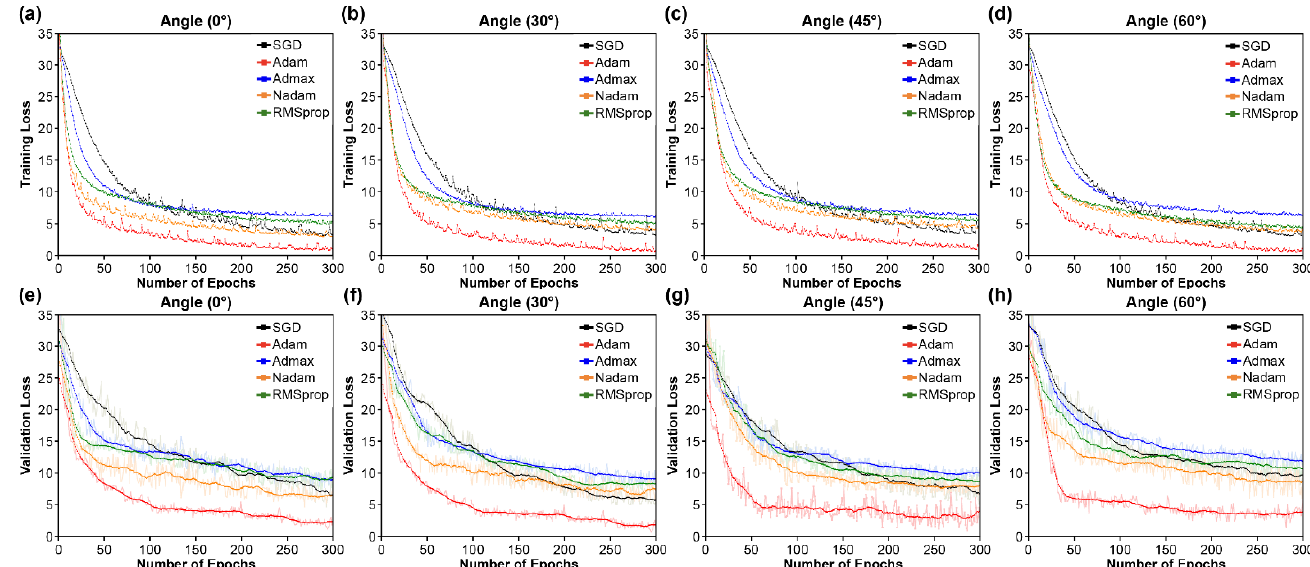
Figure 8. Loss curves comparing various optimizers. ( a – d ) Training loss at ( a ) 0°; ( b ) 30°; ( c ) 45°; and ( d ) 60°; ( e – h ) validation loss at ( e ) 0°; ( f ) 30°; ( g ) 45°; and ( h ) 60°. ( d ) 60 ◦ ; ( e – h ) validation loss at ( e ) 0 ◦ ; ( f ) 30 ◦ ; ( g ) 45 ◦ ; and ( h ) 60 ◦